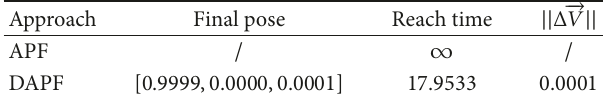
Table 4: Results of scenario 2.